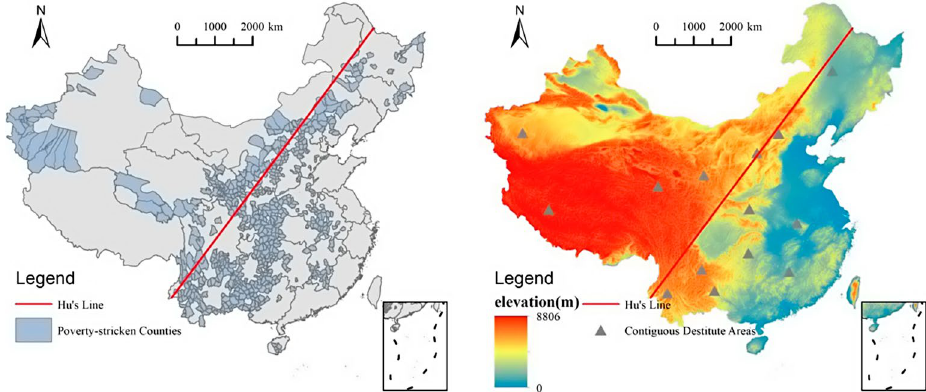
Figure 1. Spatial distribution characteristics of rural poverty in